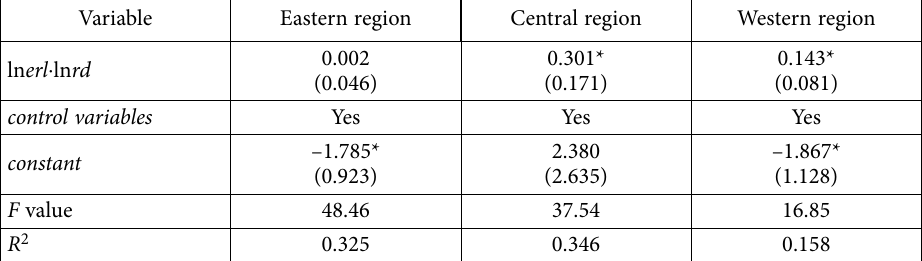
Table 7. Effect of R&D investment (source: The data in the table are calculated by the software of STATA)